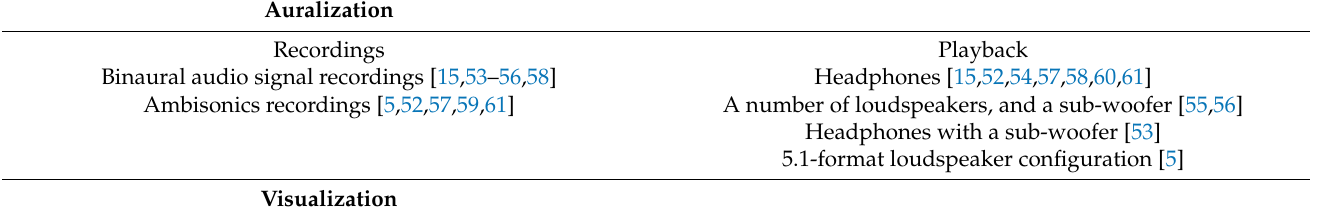
Table 2. Auralization and visualization during the participatory experiments. HMD: head-mounted display.